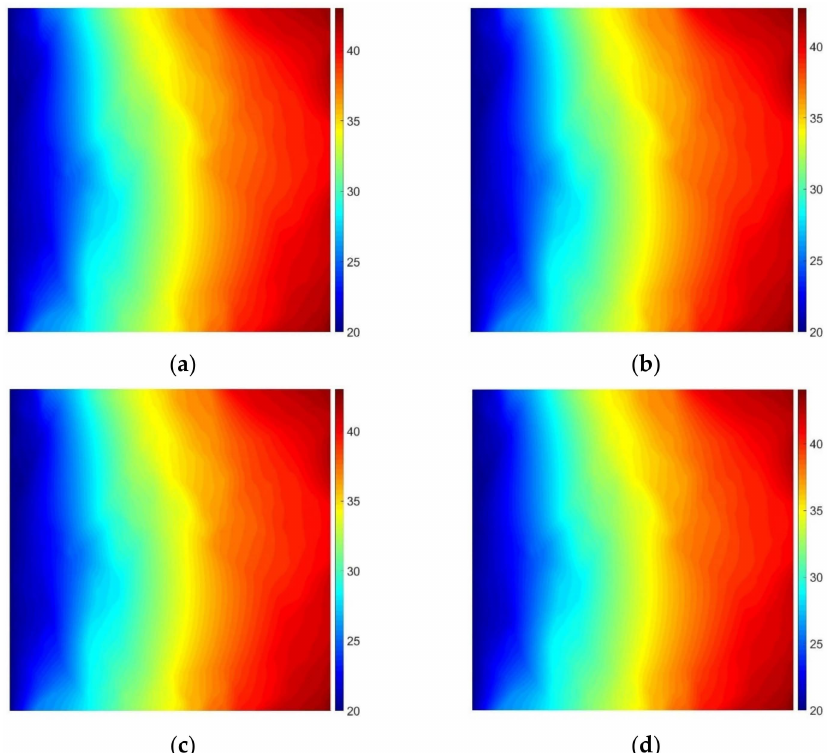
Figure 10. Map of temperature [ ◦ C] obtained using the overkill mesh ( a ) and meshes corresponding to the approximated geometry using shortest edge elimination ( b ), local geometry enhancement ( c ), and convex subdomain approach ( d